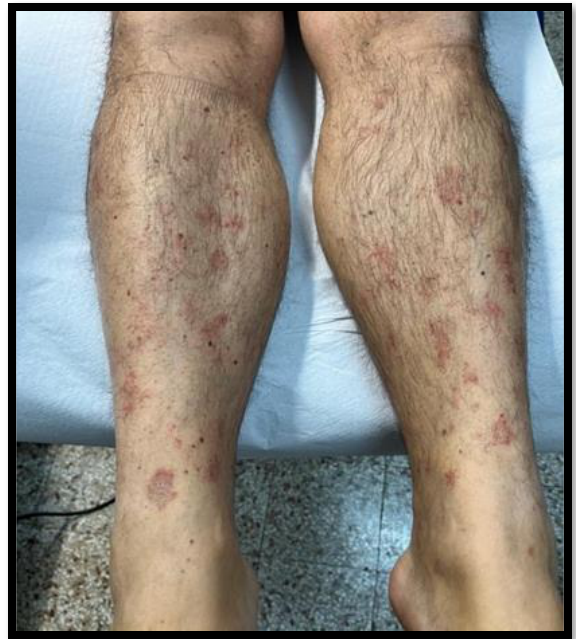
Figure 1. Erythematous annular patches on lower limbs with purpuric peripheral areas and central clearing.